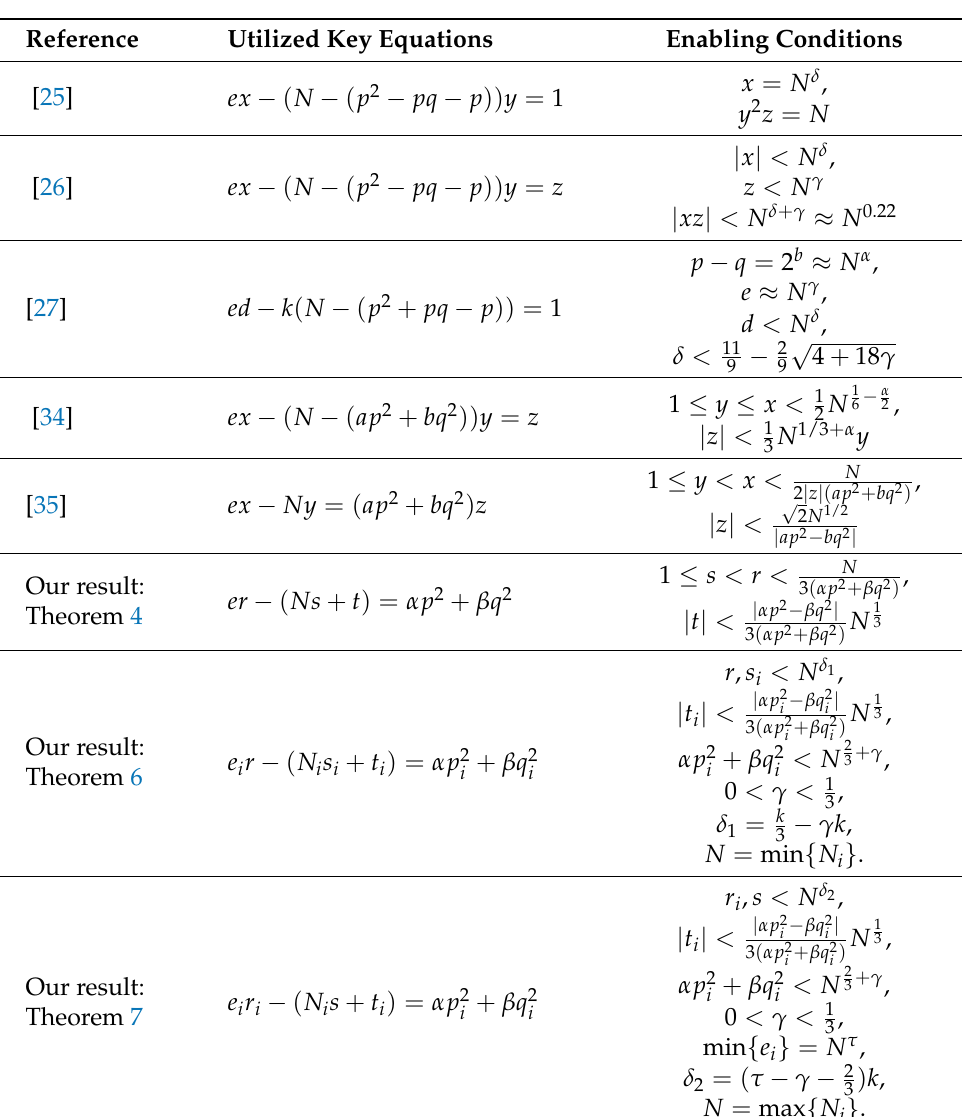
Table 2. Comparison of Our Results Against Previous